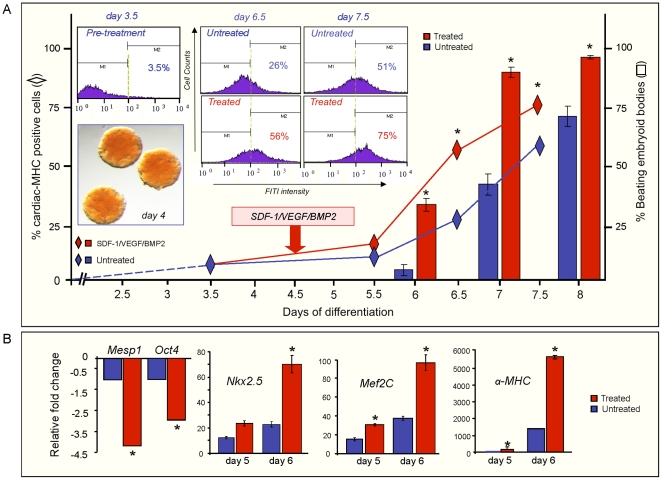
Targeted treatment with SDF-1/VEGF/BMP2 increases cardiogenic yield.(A) α-MHC R1 embryonic stem cells were differentiated by the hanging drop method. Baseline embryoid body (EB) beating activity (columns) and FACS-gal α-MHC positive cell embryoid body composition (diamonds) were quantified (blue). Floating EBs (inset) transferred to gelatinized 6 well plates in the evening of day 4 were treated with SDF-1 (100 ng/mL), VEGF (10 ng/mL), and BMP2 (10 ng/mL) or differentiation media alone at Day 4.5. EBs were collected each day for FACS-gal analysis, RT-PCR and X-gal staining. Beating activity was recorded daily for each treatment condition for ∼300 EBs. Beating activity is represented by columns (blue for baseline, red for treatment), % cardiac-MHC-Lac Z positive cells are represented by diamonds (blue, red respectively). (B) RT-PCR analysis for selected pluripotency (Oct4), pre-cardiac mesoderm (Mesp1) and canonical cardiac (Nkx2.5, MEF2C, cardiac-MHC) transcripts. Red bars represent treatment with SDF-1, VEGF and BMP2; blue bars represent the baseline, untreated condition.